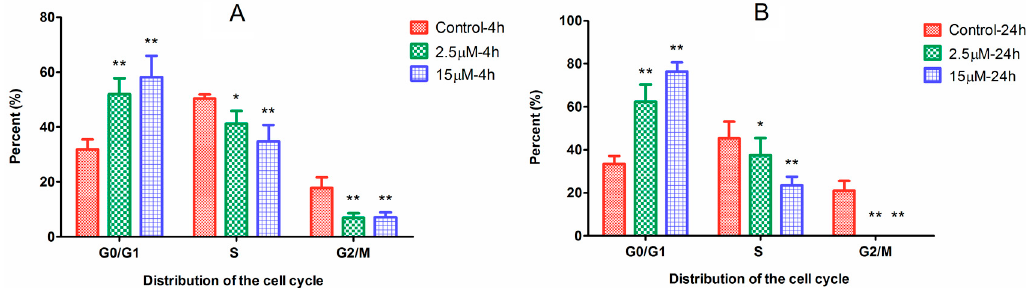
Figure 3. Effects of different dose Ara-C on cell cycle arrest in HL-60 cells at different times. ( A ) 4 h; ( B ) 24 h. p -Value of less than 0.05 (* p < 0.05, ** p < 0.01, compared with the control group) are considered significant.